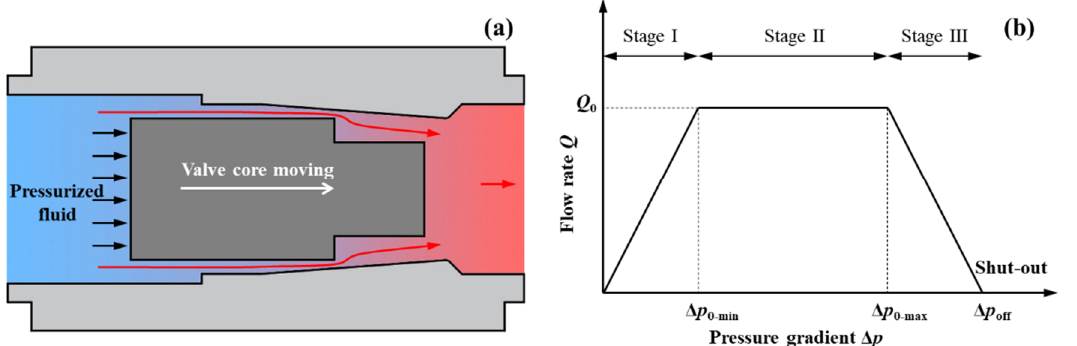
Figure 2. Working principle of the MPV: ( a ) Schematic valve actuation under pressurized fluid; ( b ) Ideal flow rate versus pressure gradient characteristic.